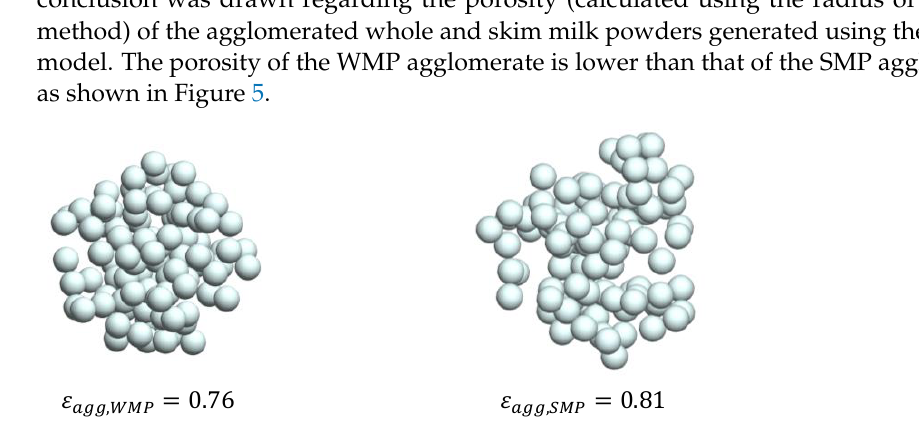
Figure 5. The agglomerates generated using the MPTSA model with their porosity values for the whole milk powder ( left ) and the skim milk powder ( right ).